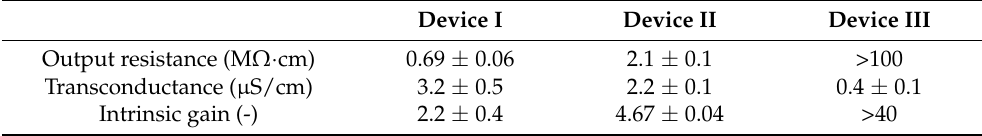
Figure 4. Output characteristics of ( a ) Device I, ( b ) Device II and ( c ) Device III. Gate voltages are 0, 5, 10, 15, 20, 25 and 30 V. Table 1. Output resistance, transconductance and intrinsic gain of the devices. The average and standard deviation were calculated among 4 samples of Device I, 3 samples of Device II and 2 samples of Device III. Only lower limit of the output resistance and intrinsic gain could be estimated in Device III because of the noise and the very small slope in the output characteristics.